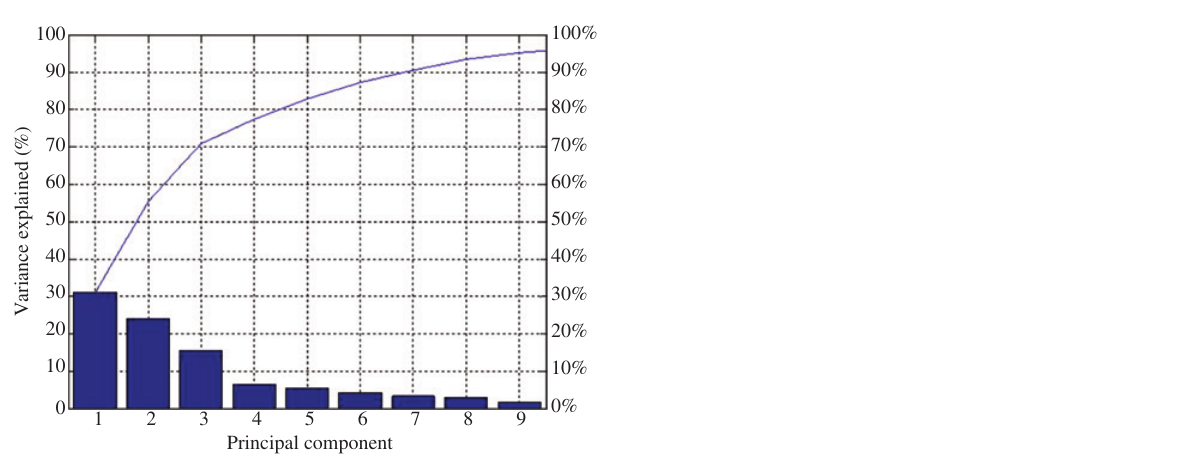
Figure 5: The Results of PCA Dimensionality Reduction in the Fifth Group of